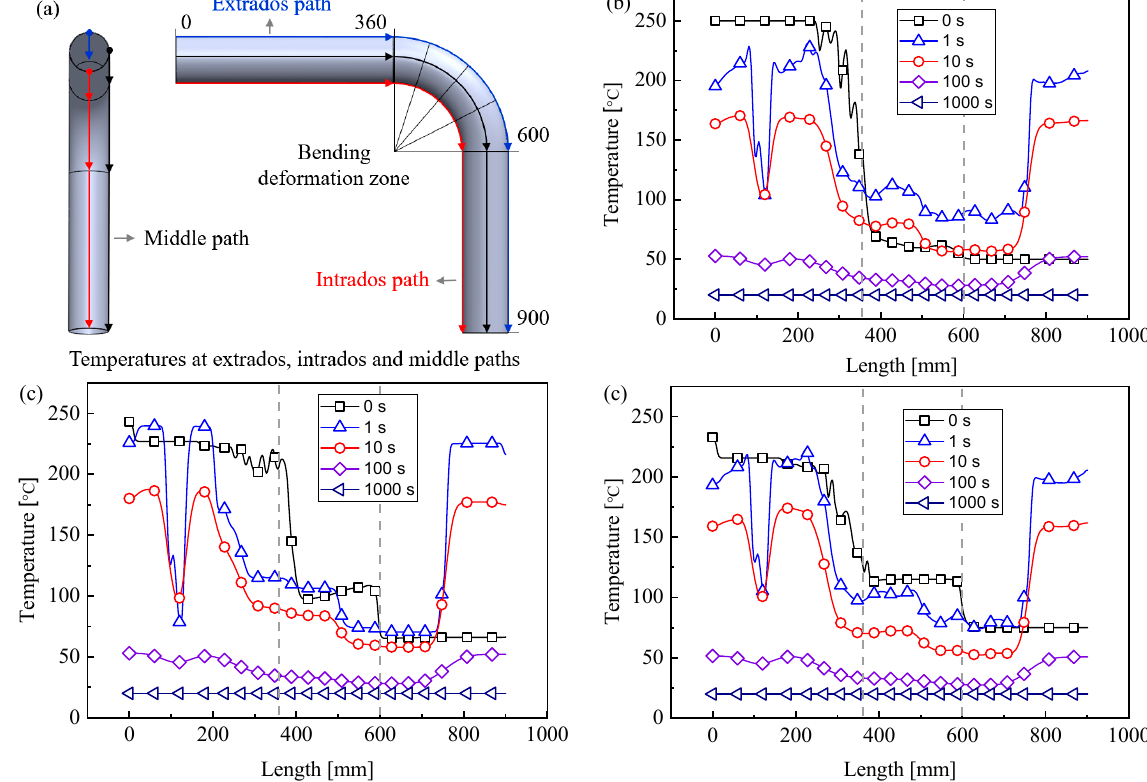
Figure 9. Evolution of temperature field with unloading process under 90° bending at 250 °C forming condition: ( a ) schematic of temperature paths; ( b ) temperatures in the extrados; ( c ) temperatures in the middle; ( d ) temperatures in the intrados.